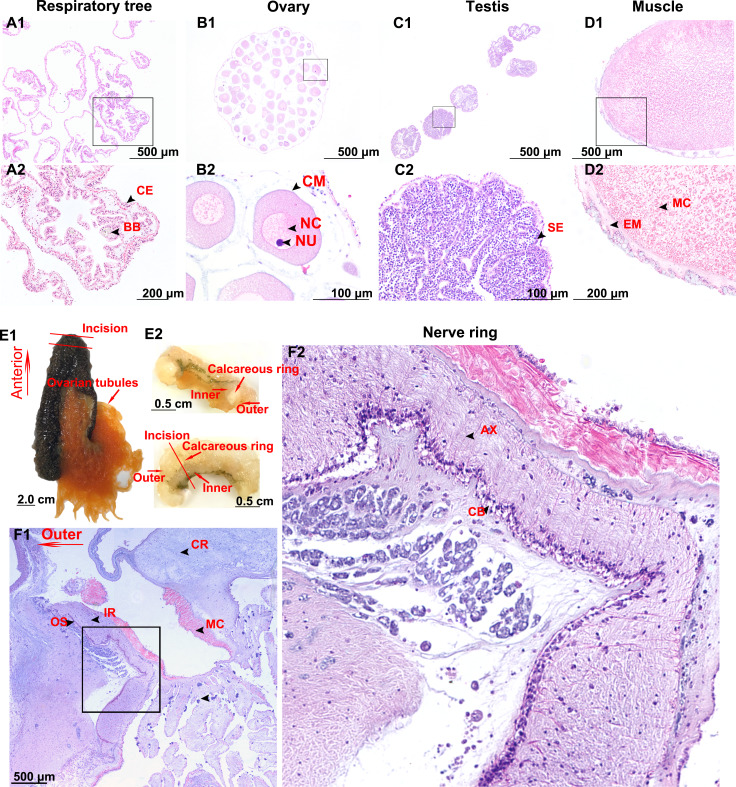
General morphology and histology of Apostichopus japonicus tissues.(A–D) Light micrographs of H and E stained sections of respiratory tree, ovary, testis and muscle. CE, coelomic epithelium; BB, brown body; CM, cell membrane; NC, nucleus of oocytes; NU, nucleolus of oocytes; SE, spermatogenic epithelium; EM, epithelium of muscle; and MC, myocyte. (E) Gross anatomy of the anterior part (ANP). (F) Light micrographs of H and E stained sections of ANP and histology of nerve ring (NR). OS, outer surface; IR, internal region; CR, calcareous ring; AX, axon of neuron; and CB, cell body of neuron. All data shown are representative of at least three independent experiments.